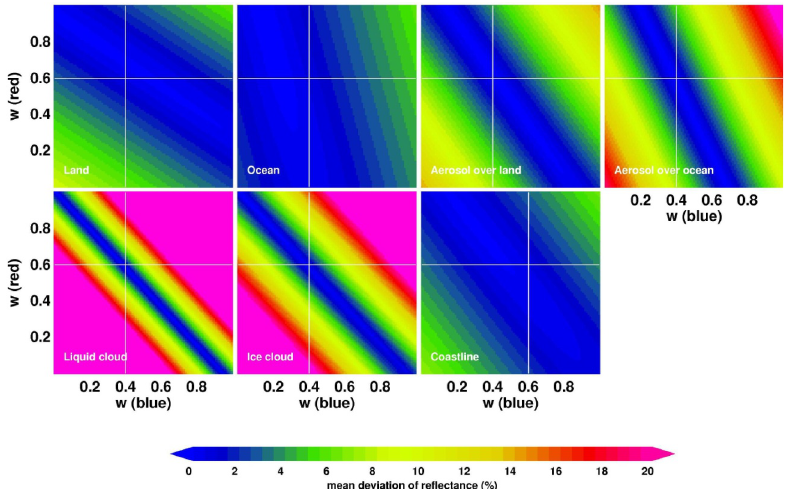
Figure 6a Fig. 6a. Mean difference between the synthesized and simulated green band reflectance with varying w B and w R for land, ocean, aerosol Simulation of GOES-R ABI aerosol radiance (over land and ocean), cloud (liquid and ice), and coastline for 10 June 2008. The unit is reflectance in percent. The point at w B = 0 . 4 and w R = 0 . 6 is shown for land, ocean, aerosol, and cloud. The point at w B = 0 . 6 and w R = 0 . 6 is also shown for coastline.